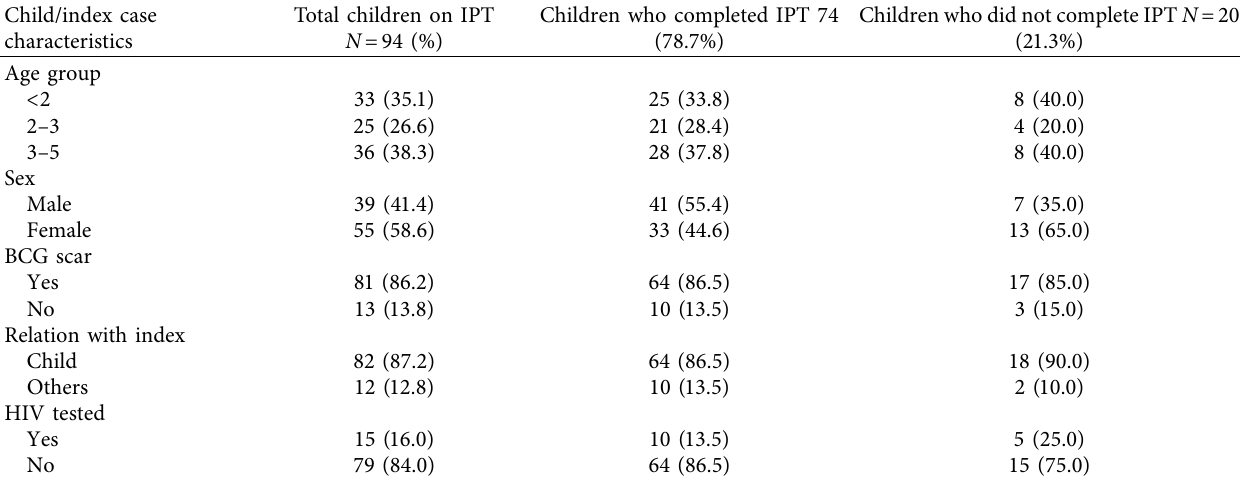
Table 2: Characteristics of child contacts after completion of six-month INH chemotherapy, 2019.